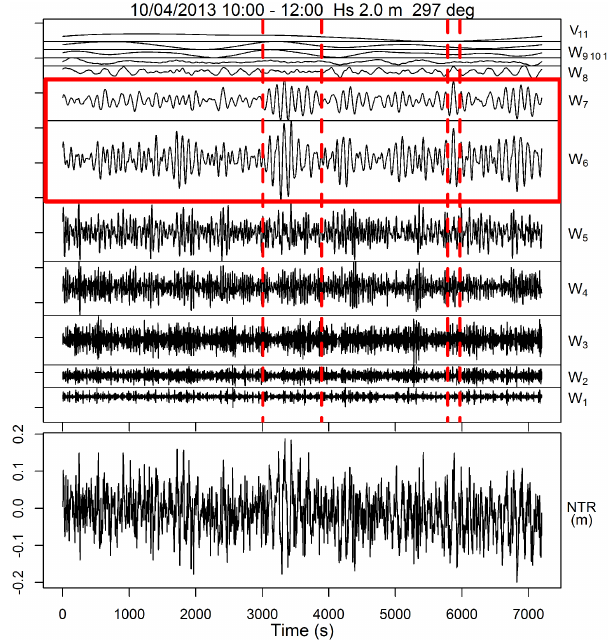
Figure 12. Discrete wavelet transform decomposition of nontide residual water level during a 2h period with an offshore signifi- cant wave height of 2.0m. Dashed vertical lines mark periods of synchronization between the W 7 ( T ≈ 118s) and W 6 ( T ≈ 111s)